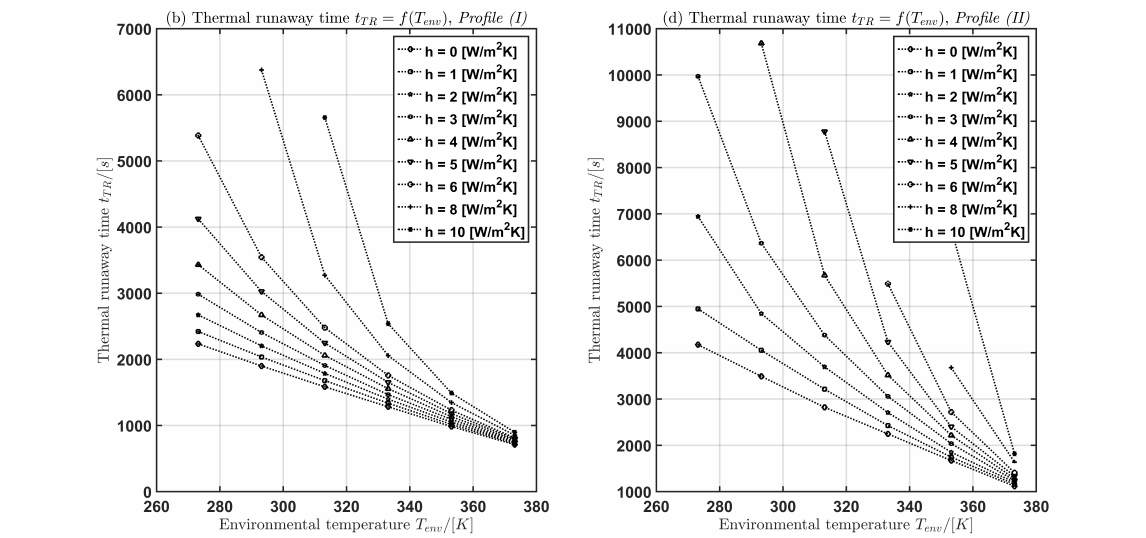
Figure 5. Thermal runaway time t TR as function of the convective heat transfer coefficient h ( a ),( b ) and as function of the environmental temperature T env ( c ),( d ) for both current profiles Profile (I) and Profile (II)